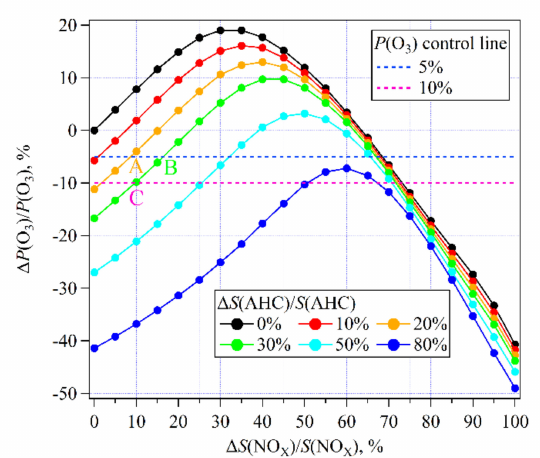
Figure 12. Relationship of P (O 3 ) relative change with relative reduction of S (NO X ) and S